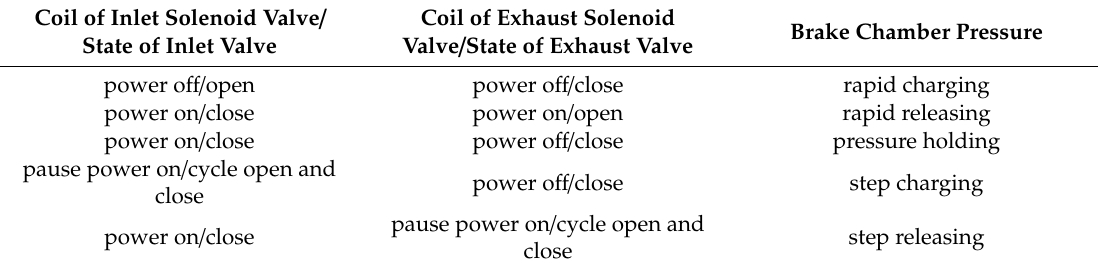
Table 1. Working states of the pneumatic ABS pressure